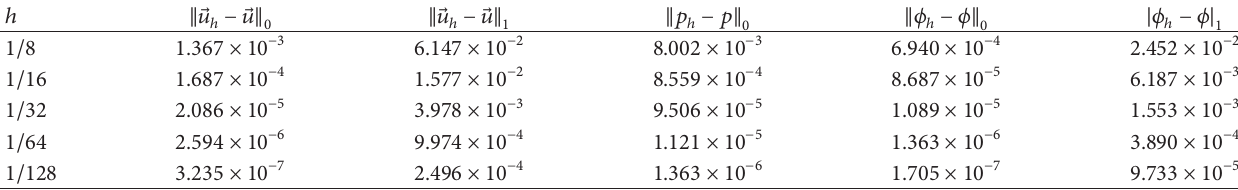
Figure 2: Convergence for the velocity of the free flow (a) and the hydraulic head of the porous medium flow (b) versus the iteration counter 𝑚 for the parallel DDM with BJS interface condition. Table 1: Errors of the finite element method for the steady Navier-Stokes-Darcy model with BJS interface